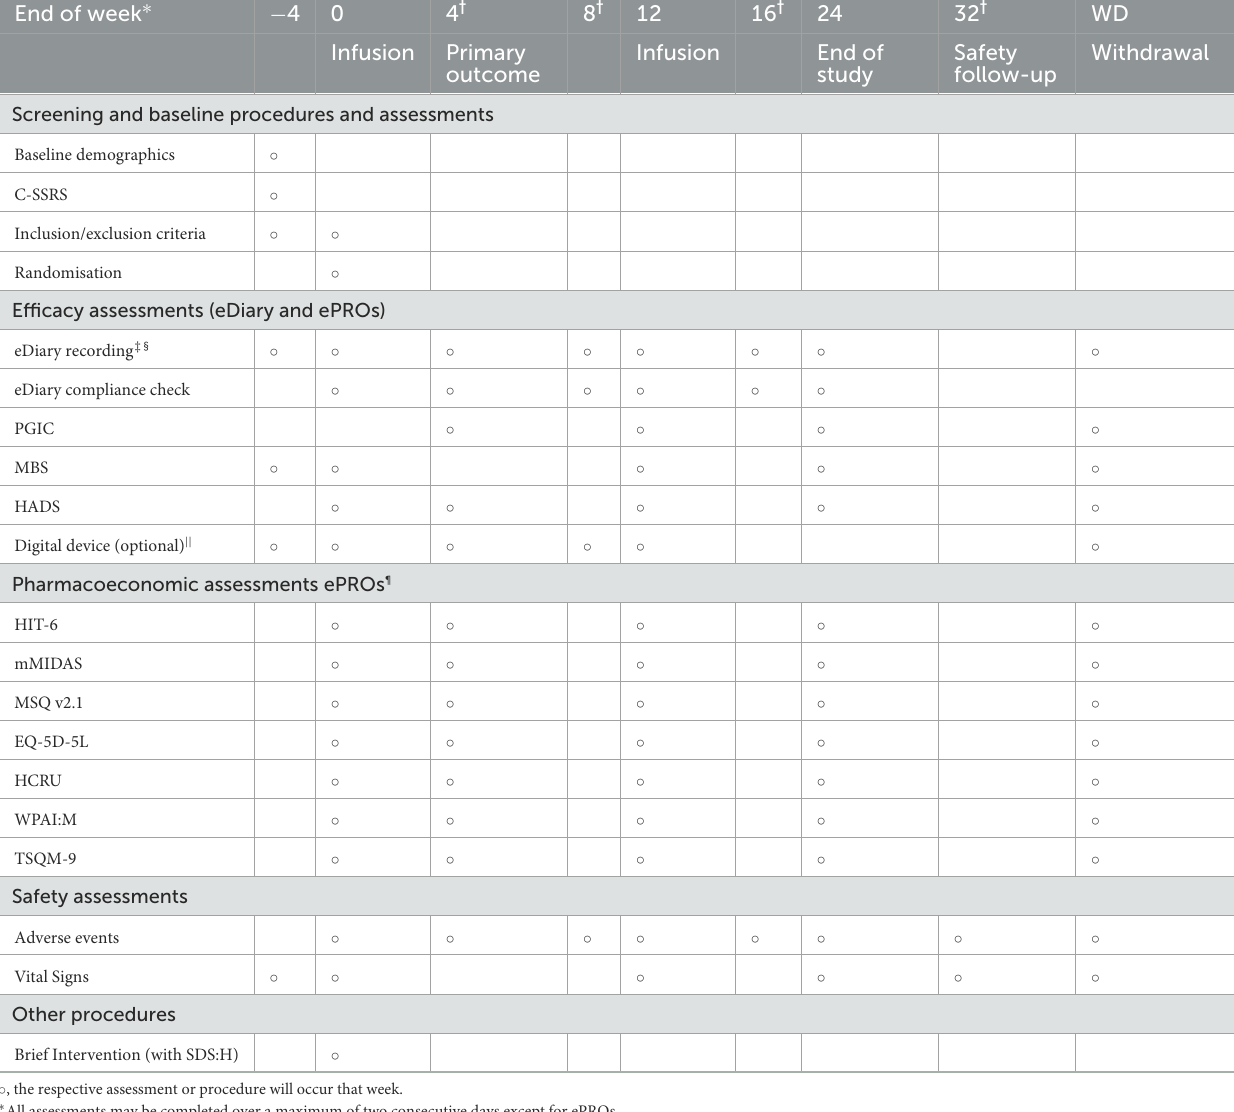
TABLE 2 Study procedures and assessments timeline.